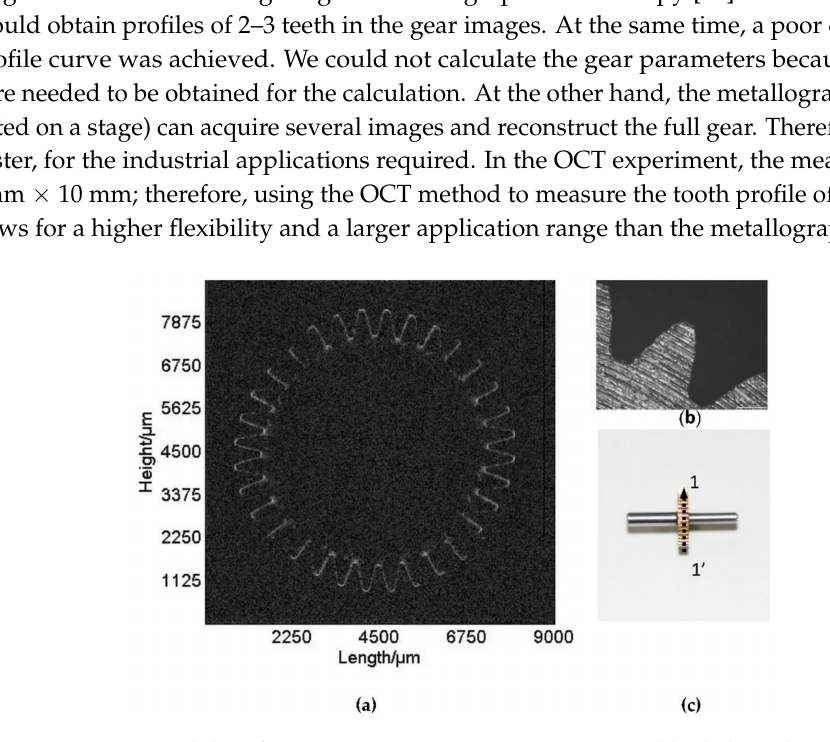
( b ) tooth profile measurement using the minimum five times magnification objective lens of the metallographic microscope; ( c ) photo of the gear body and the OCT scan line 1–1 (cid:48)